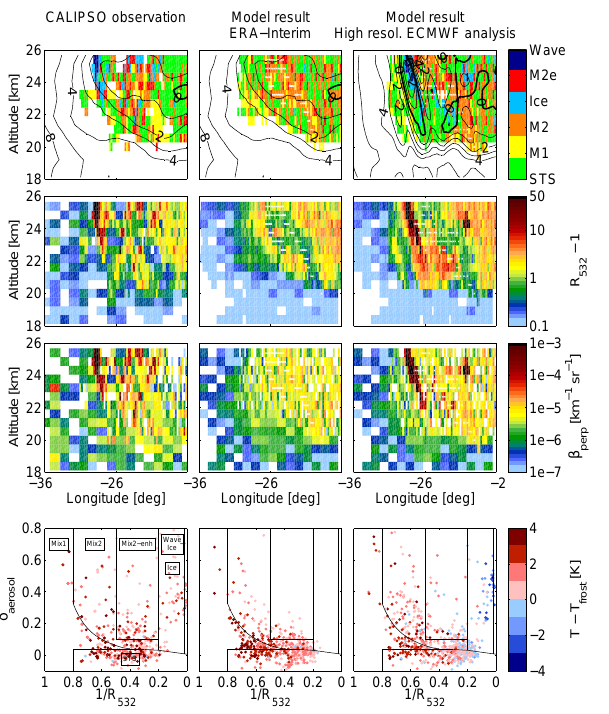
Fig. 8. 4 January 2010: CALIPSO orbit track 2010-01-04T05-03- 43Z. CALIOP measurements are shown in the left column, model results based on ERA-Interim temperature data in the middle col- umn and model results based on high-resolution ECWMF analysis temperature data in the right column. White striped areas indicate trajectories with temperatures below T NAT − 4K longer than 80h or temperatures below T NAT at the trajectory’s starting point. Con- tour lines and the color-coded data presented in the lowermost row display ERA-Interim temperatures relative to T frost in the left and middle column and ECMWF analysis temperatures in the right col- umn.